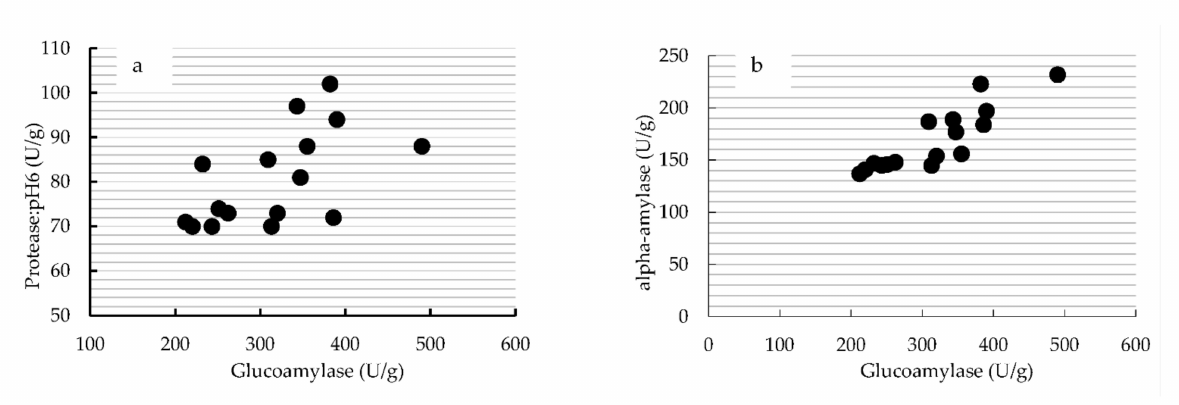
Figure 6. Correlation of enzyme activity (U/g) produced by koji starter for miso: ( a ) glucoamylase and protease (pH 6); ( b ) glucoamylase and alpha-amylase.